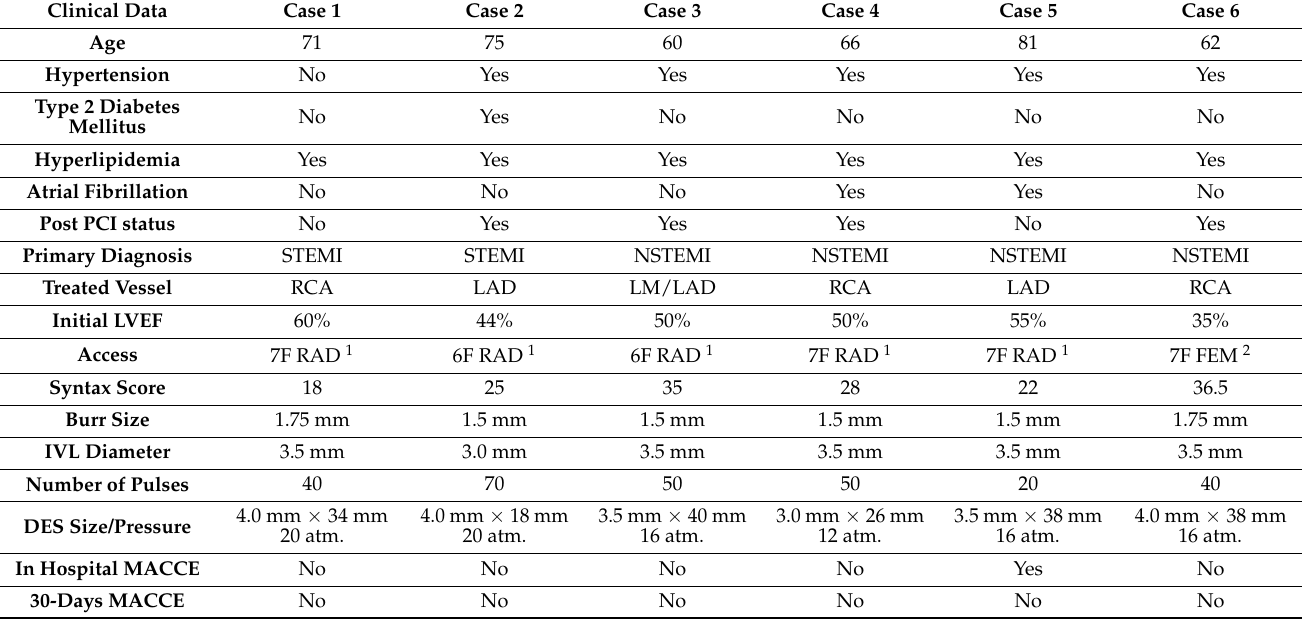
Table 1. Clinical, procedural, and postprocedural characteristics of